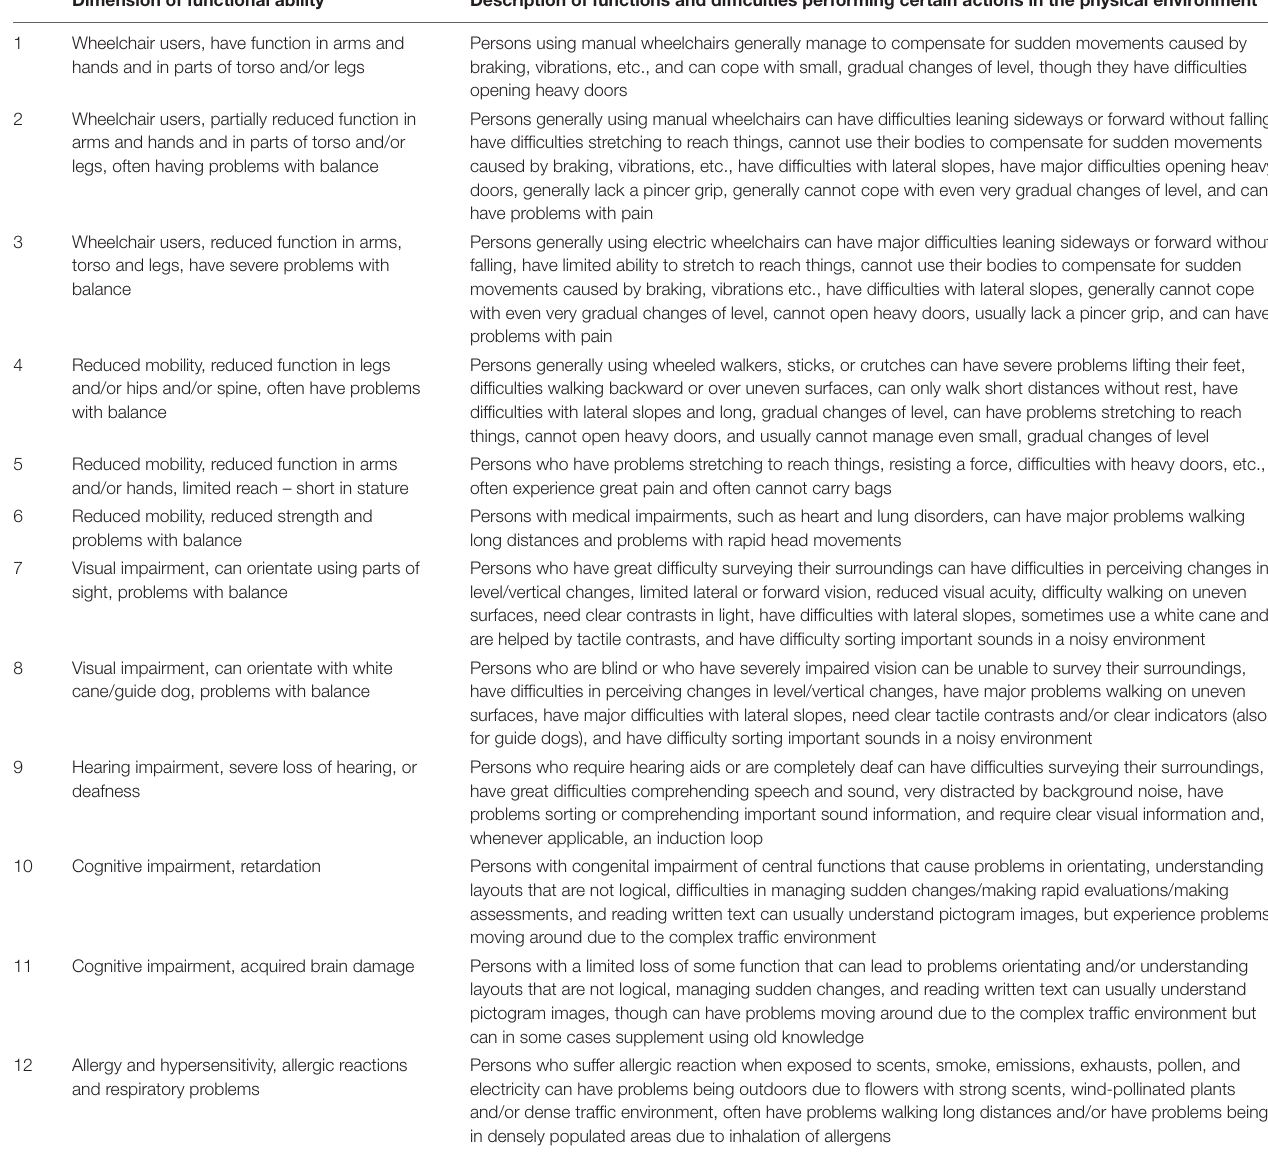
TABLE 1 | Dimensions of functional ability ( N =